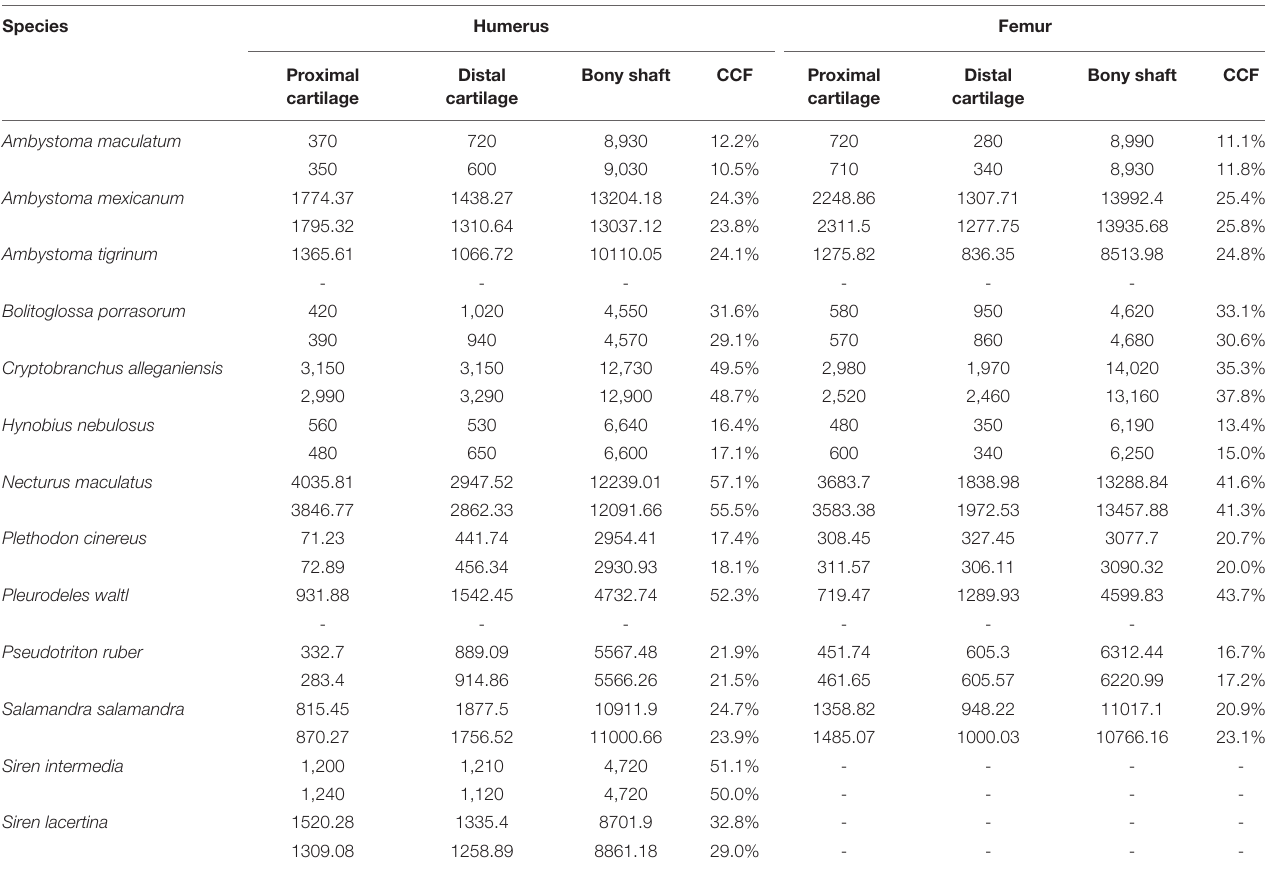
TABLE 2 | Measurements of cartilage thickness and bony shaft length taken from humerus and femur ( µ m) and calculated percentage of humerus or femur length composed of cartilage. Species Humerus